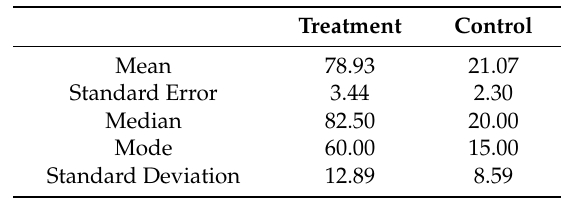
Table 6. Descriptive Summary of Quiz Scores.